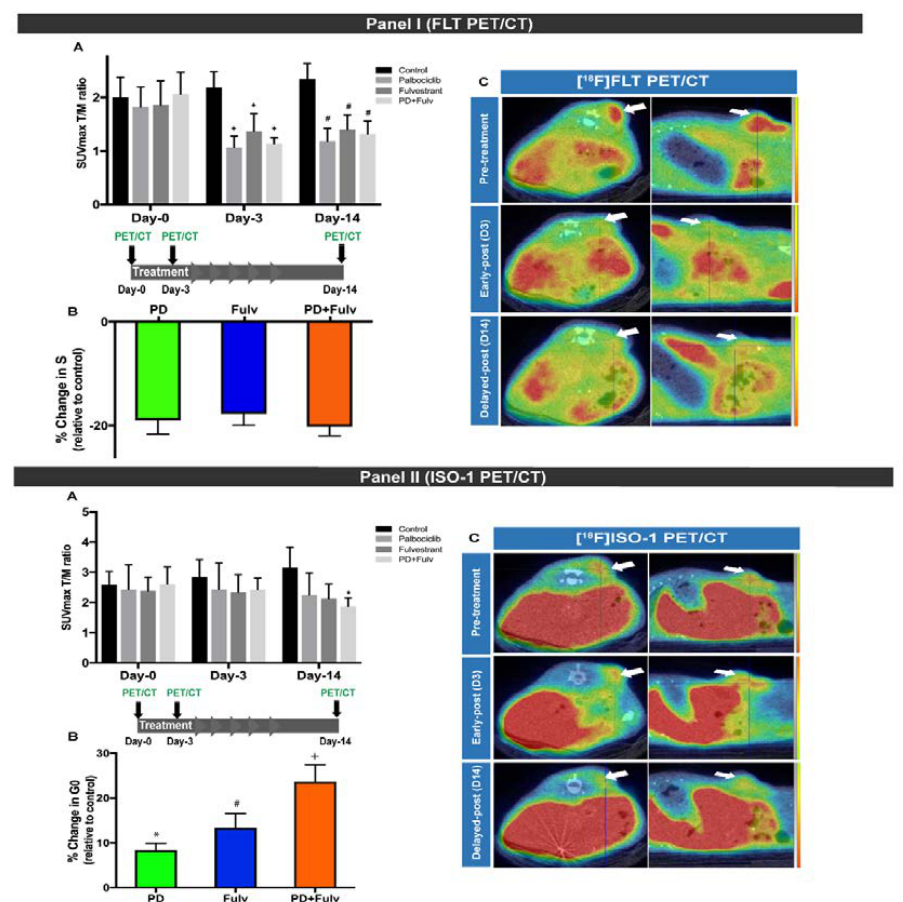
Figure 4. Panel (I): [ 18 F]FLT uptake after treatment with palbociclib (PD), fulvestrant (Fulv) or combination of both at baseline and days 3 and 14 of treatment. ( A ) Tumor uptake as T / M ratio in controls and treated mice, showing persistent reduction of the T / M ratio in treated mice on days 3 and 14. ( B ) Changes in S-phase fraction relative to controls on day 14 of treatment, demonstrating comparable S-phase reduction across di ff erent treatment groups. ( C ) Representative PET / CT images of one mouse from the combination treatment group, demonstrating dramatic decline of [ 18 F]FLT uptake on day 3, which is persistent on day 14. Panel (II): [ 18 F]ISO-1 uptake after treatment with palbociclib (PD), fulvestrant (Fulv) or combination of both at baseline and days 3 and 14 of treatment. ( A ) Tumor uptake as the T / M ratio in controls and treated mice, showing the delayed reduction of the T / M ratio in treated mice, seen only on day 14. ( B ) G 0 arrest relative to controls on day 14 of treatment, more pronounced in the combination therapy group. ( C ) Representative PET / CT images of one mouse from the combination treatment group, demonstrating delayed decline in [ 18 F]ISO-1 uptake on day 14. *, p < 0.05; #, p < 0.01 and + , p < 0.001, compared with control group of the respective day. Reproduced with permission from reference